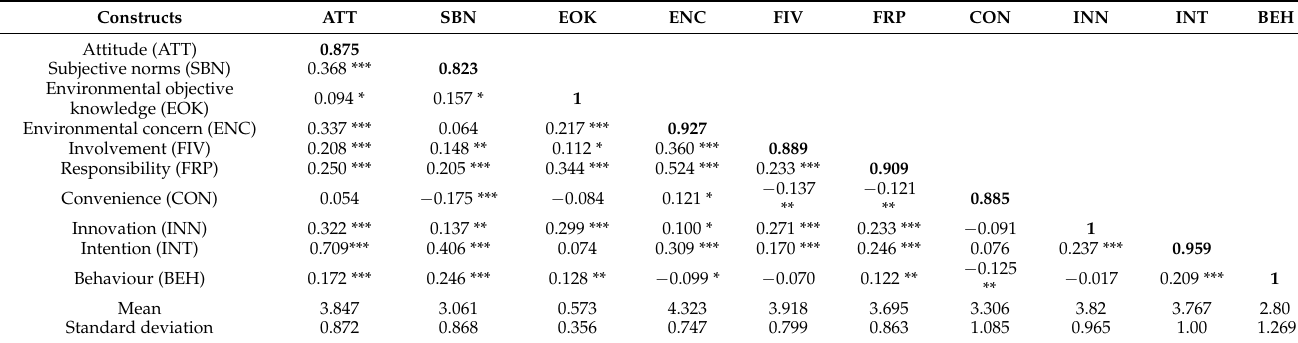
Table 6. Descriptive statistics and correlation among the constructs with square roots of average variance extracted.